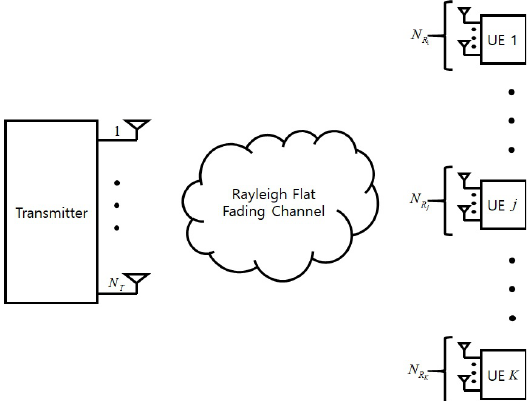
Figure 1. The multi user multiple-input multiple-output (MIMO) downlink system model.